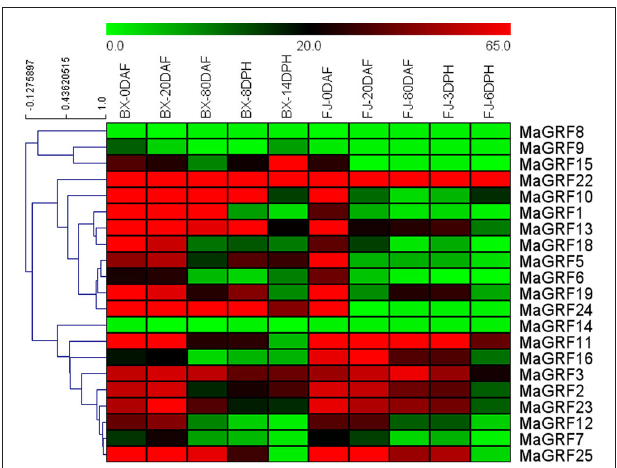
FIGURE 6 | Expression analysis of 14-3-3s in different stages of fruit development and ripening in two banana varieties. Fruits of 0, 20, and 80 DAF in BX and FJ varieties were sampled to assess the expression patterns of 14-3-3 genes during fruit development. Fruits at 8 and 14 DPH in BX and at 3 and 6 DPH in FJ were sampled to examine the expression patterns of 14-3-3s during postharvest ripening process. The heat-map was created based on transcriptomic data of 14-3-3s from two independent experiments. The scale represents relative signal intensity values. FIGURE 7 | Expression analysis of 14-3-3s in response to cold, salt,